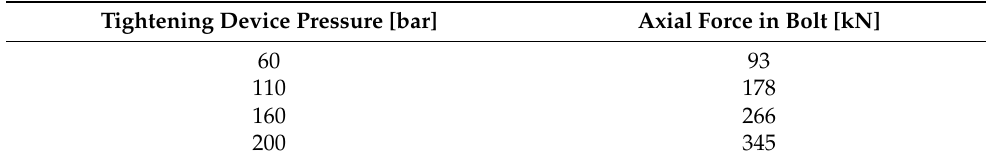
Table 1. Axial forces at defined